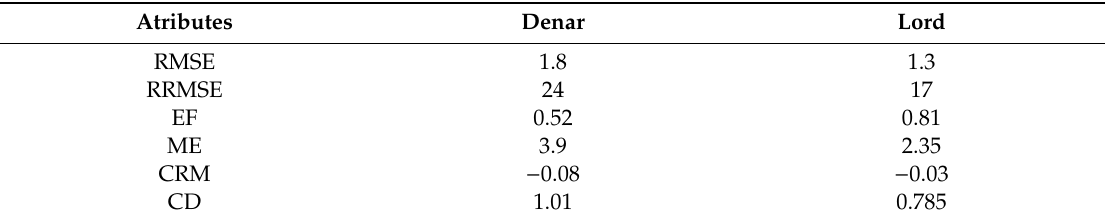
Table 7. Statistical indicators of performance of the WOFOST model. ME = maximum error; RMSE = root mean square error; CRM = coefficient of residual mass; EF = modelling efficiency; CD = coefficient of determination.